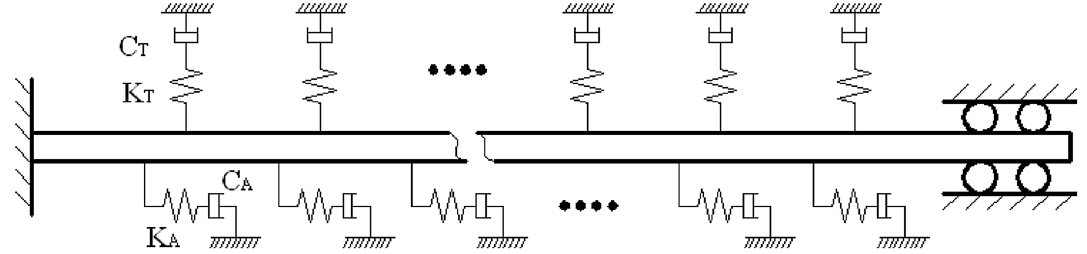
Fig. 1 Casing strings mechanical model in